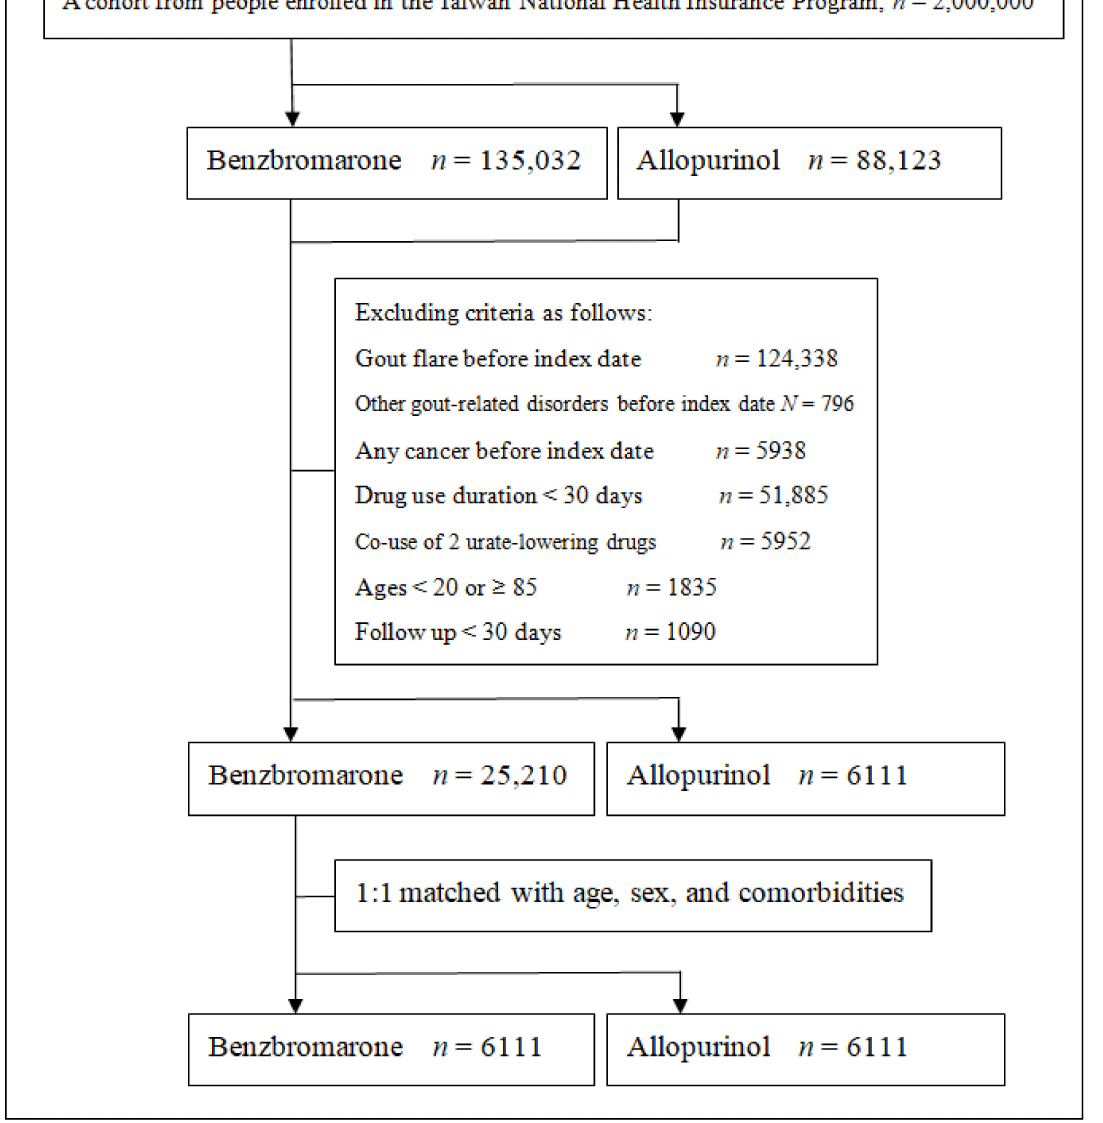
Figure 1. A flow chart of the selection of study